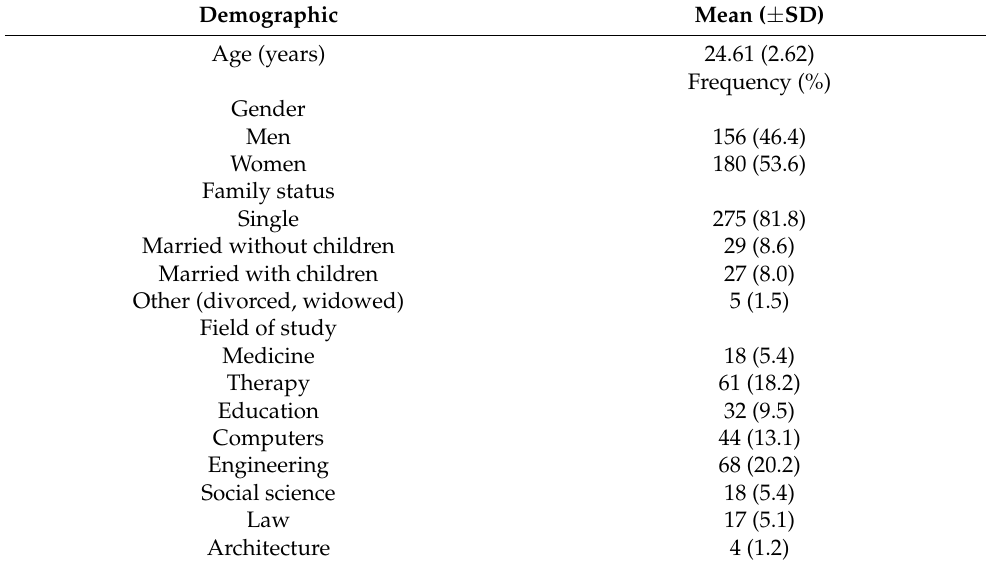
Table 1. Participants’ demographic